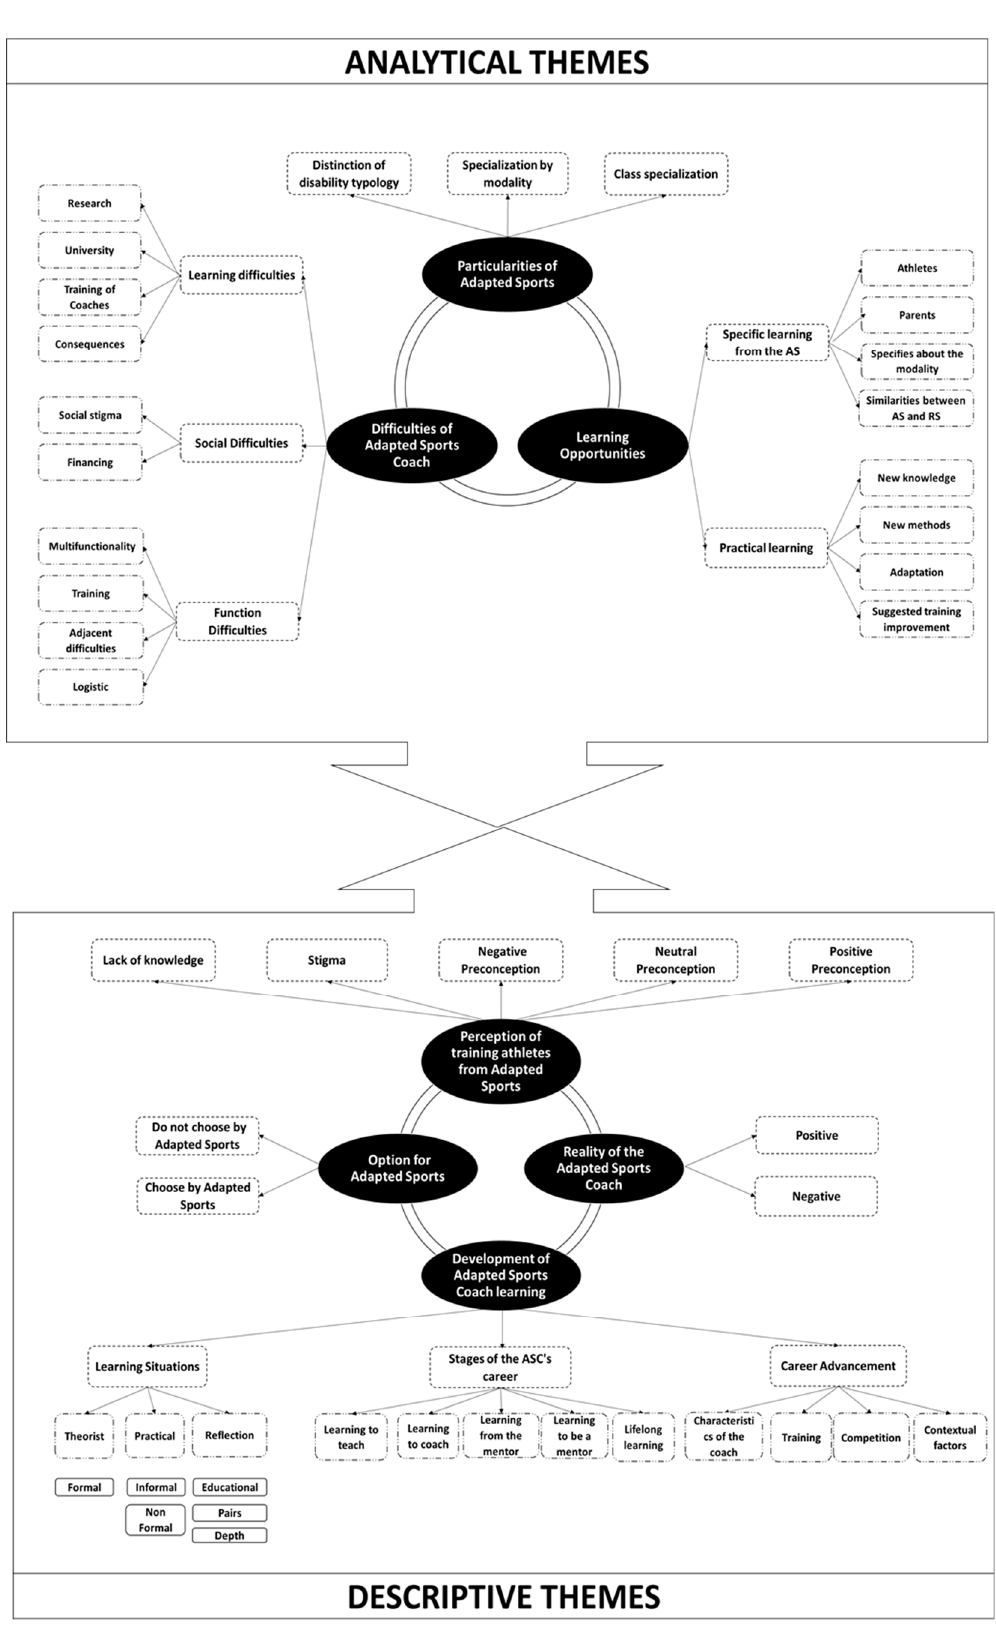
Figure 2. Conceptual Model of Career Development of Adapted Sports Coaches.